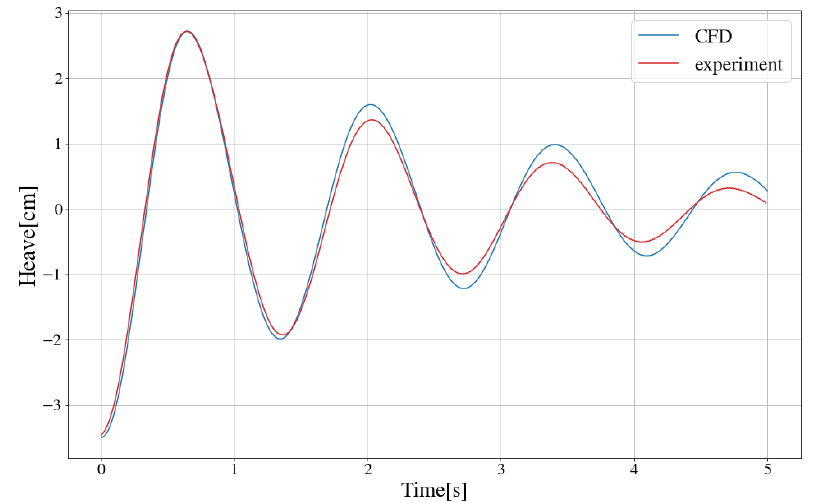
Figure 11. Time series of the free decay test of